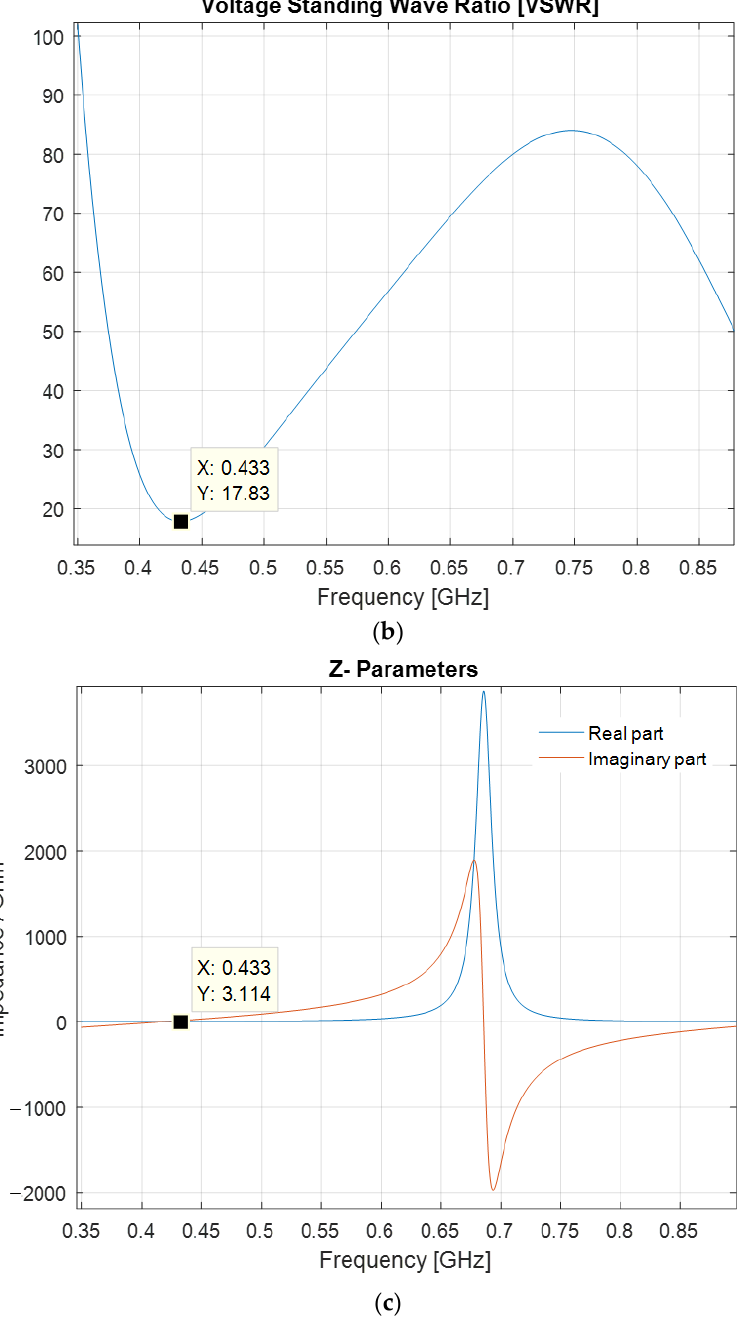
Figure 14. Impedance matching figures at the antenna input: ( a ) Reflection coefficient; ( b ) Voltage standing wave ratio; ( c ) Input impedance.